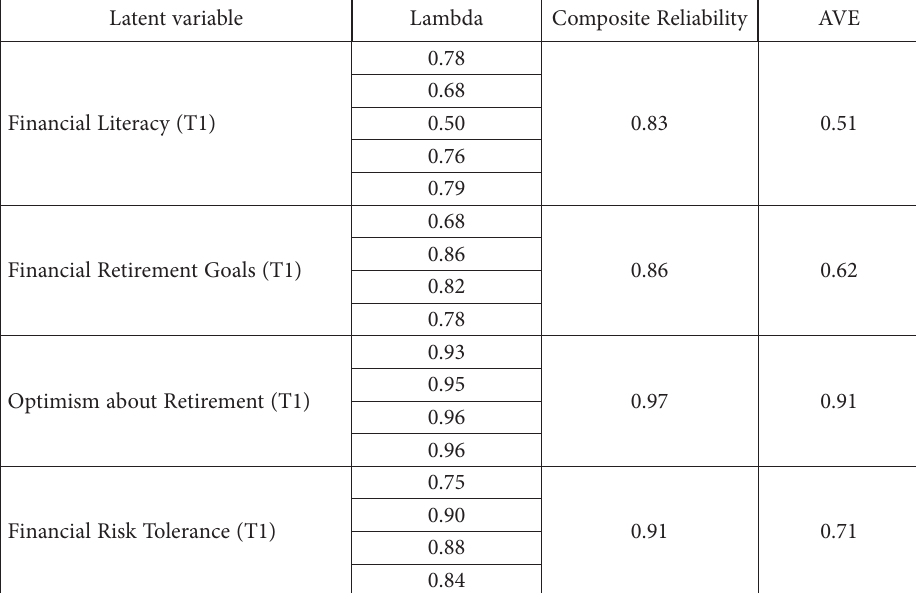
Table 3. Measurement model: Reliability and convergent